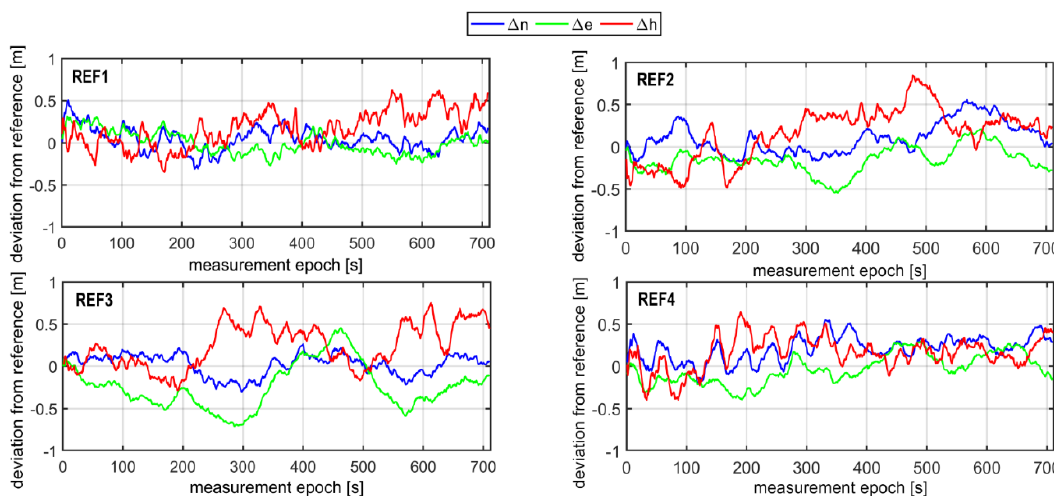
Figure 9. The GPS-EGNOS positioning accuracy at 4 permanent ASG-EUPOS stations, located around the airfield, based on GPS L1, EGNOS and Kalman filtering.